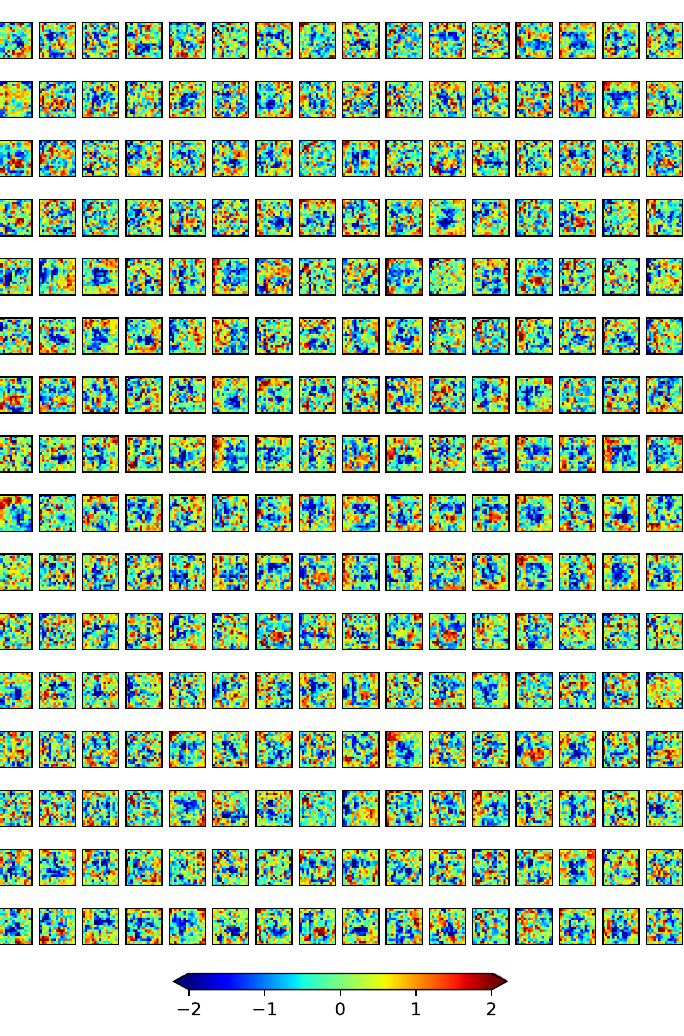
Figure A5. Selected feature maps with a size of 16 × 16 pixels that are output from the convolution layer (A4) shown in Figure 9, for the case shown in Figure A2. Half (256) of the 512 feature maps are arbitrarily shown. Each image shows the normalized signal of the feature map with a mean of 0 and standard deviation of 1.